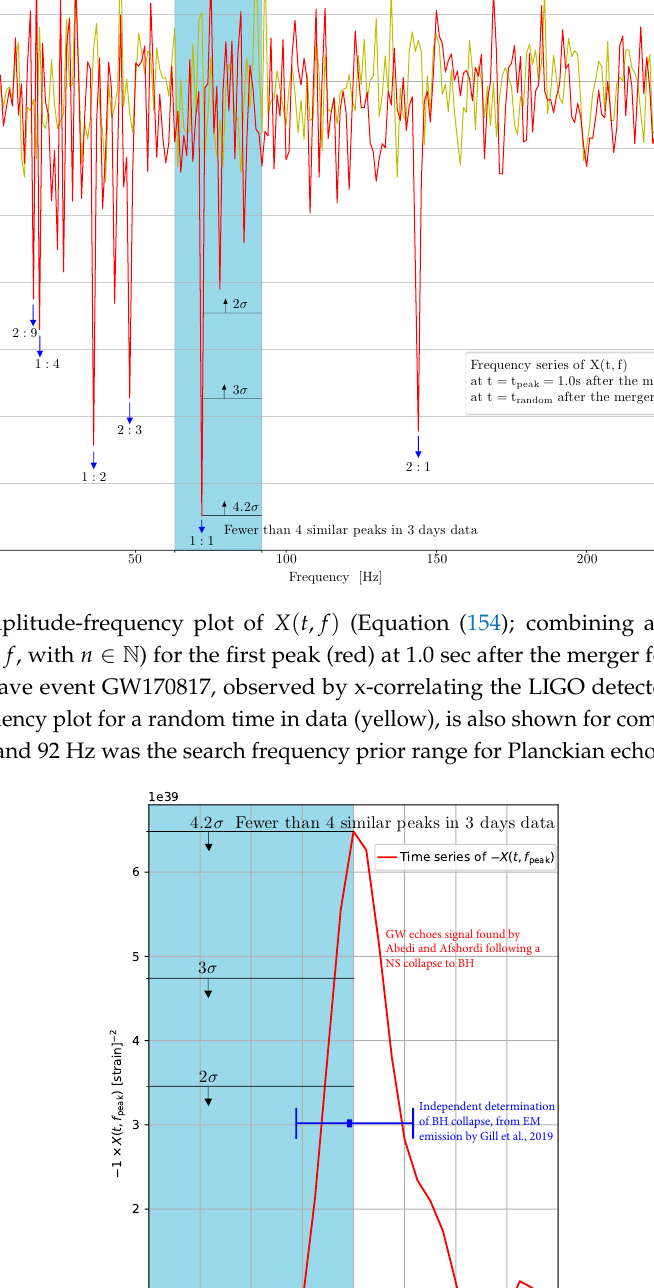
Section Error-bar 0.26 −